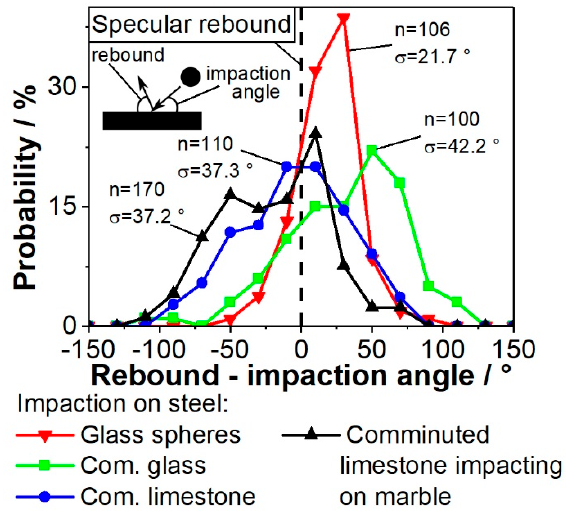
Figure 7. Angular imperfection probability distributions measured in the impact test bed with a microscopic lens for different materials. n is the number of evaluated particles and σ is the standard deviation.